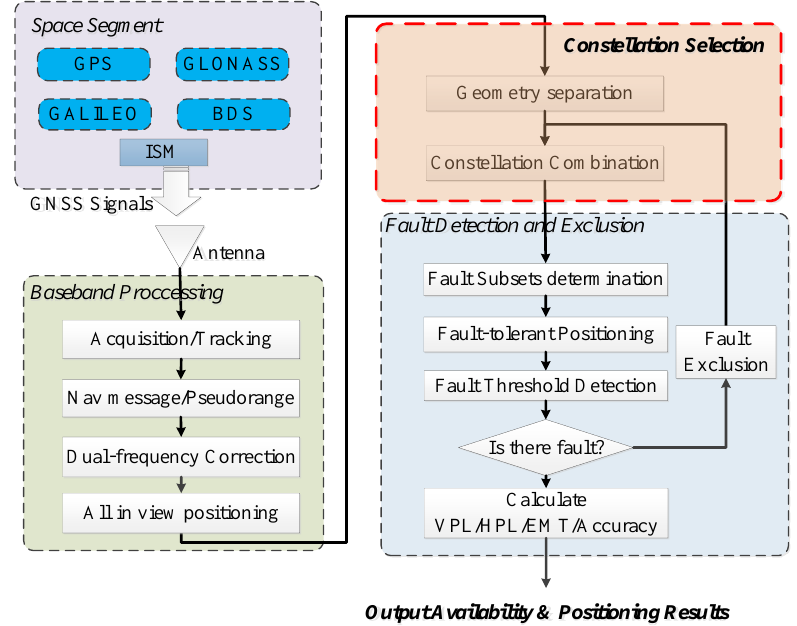
Figure 4. Implementation of ARAIM with constellation dynamic selection.